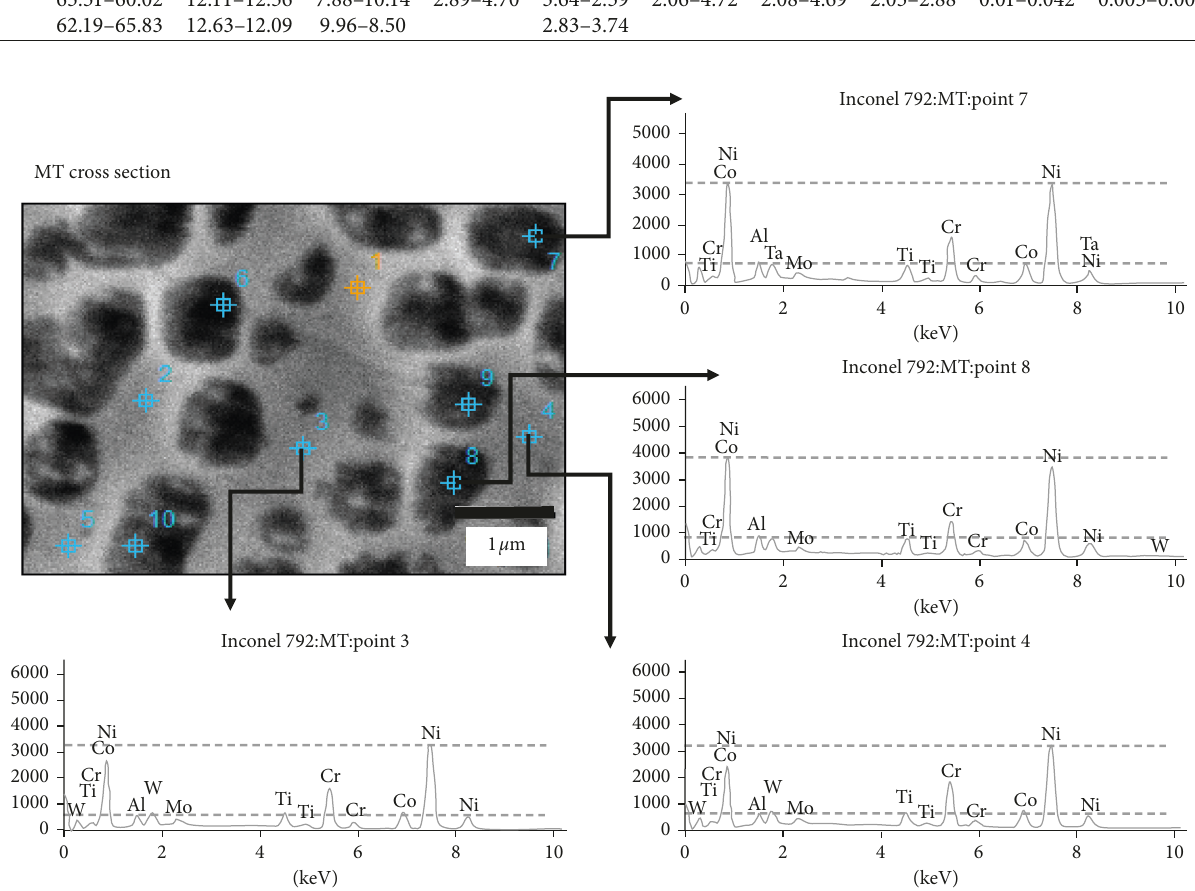
Figure 4: Analysis by EDX of the sample exposed at MT, near leading edge and suction side of the